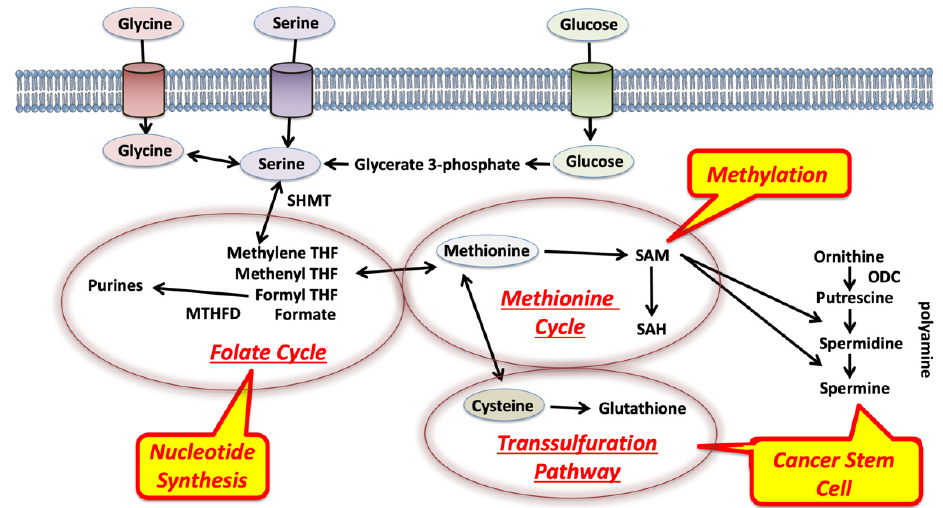
Figure 2. Biochemical schema of 1C metabolism. One-carbon metabolism couples with three reactions: folate cycle, methionine cycle, and transsulfuration pathway [16]. The folate cycle produces purines and nucleotide synthesis. The methionine cycle plays a critical role in the control of methylation of target DNA, RNA, and proteins. The transsulfuration pathway is involved in the regulation of cancer stem cells by the reduction control of cells. Polyamines control cell proliferation and differentiation in cancer stem cells. ODC, ornithine decarboxylase; SAM, S-adenosylmethionine; SAH, S-adenosylhomocysteine.